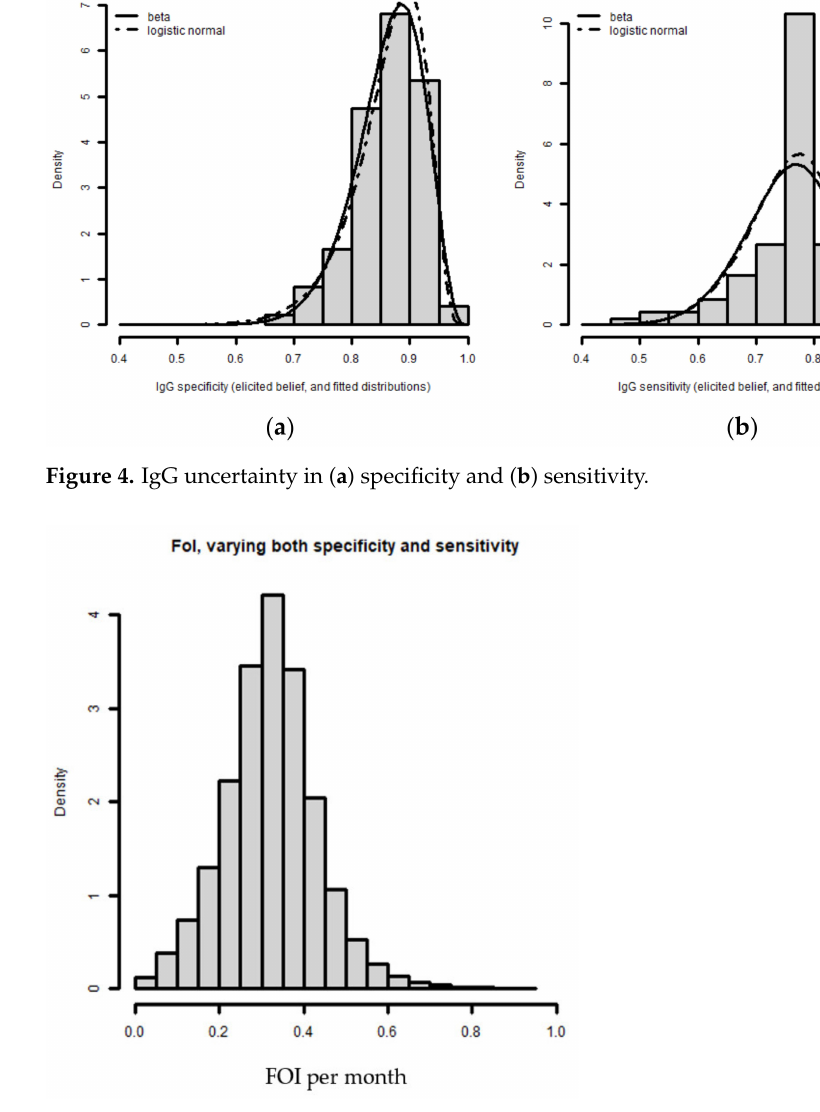
Figure 5. Estimation of the force of